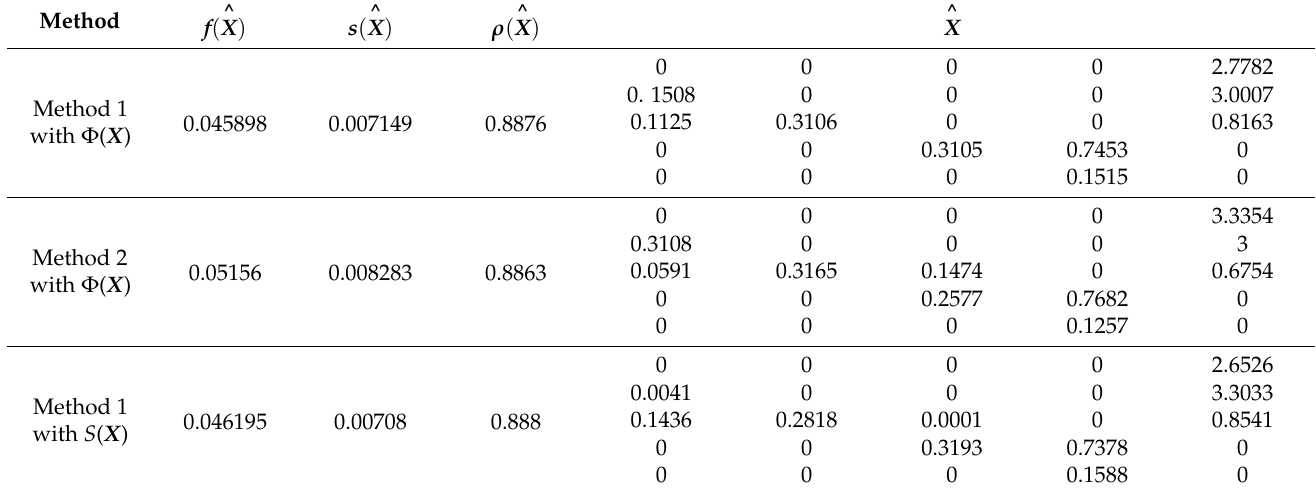
Table 7. Results for Example